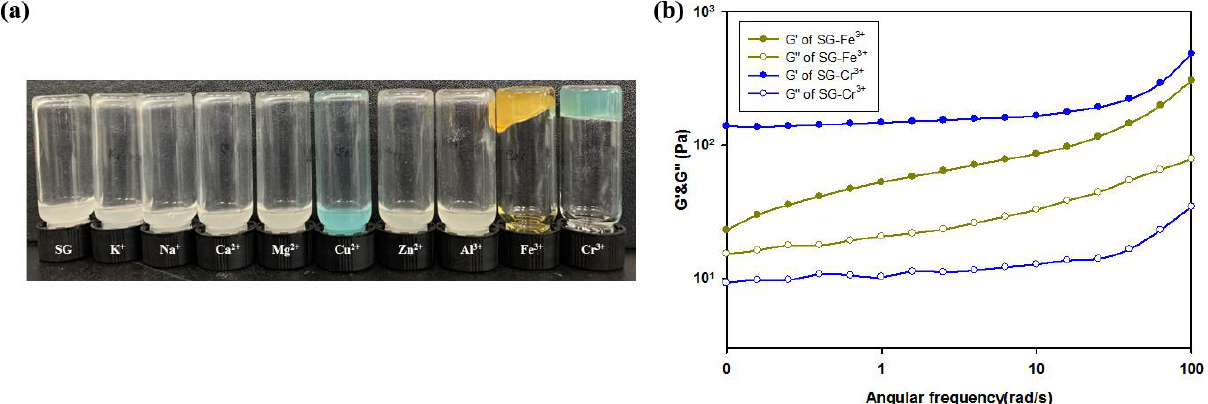
Figure 2. Gelling performance of succinoglycan (SG) with respect to the addition of various metal ions: ( a ) Inverted vial test after mixing various metal ion solutions (0.25 M) with aqueous succinoglycan solution (wt. 2%), and ( b ) Frequency sweep of aqueous SG solution containing metal ions (SG-Fe 3+ and SG-Cr 3+